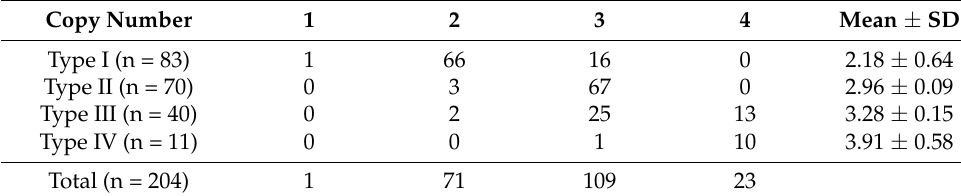
Table 1. SMA types and copy number of SMN2 in SMN1 -deleted